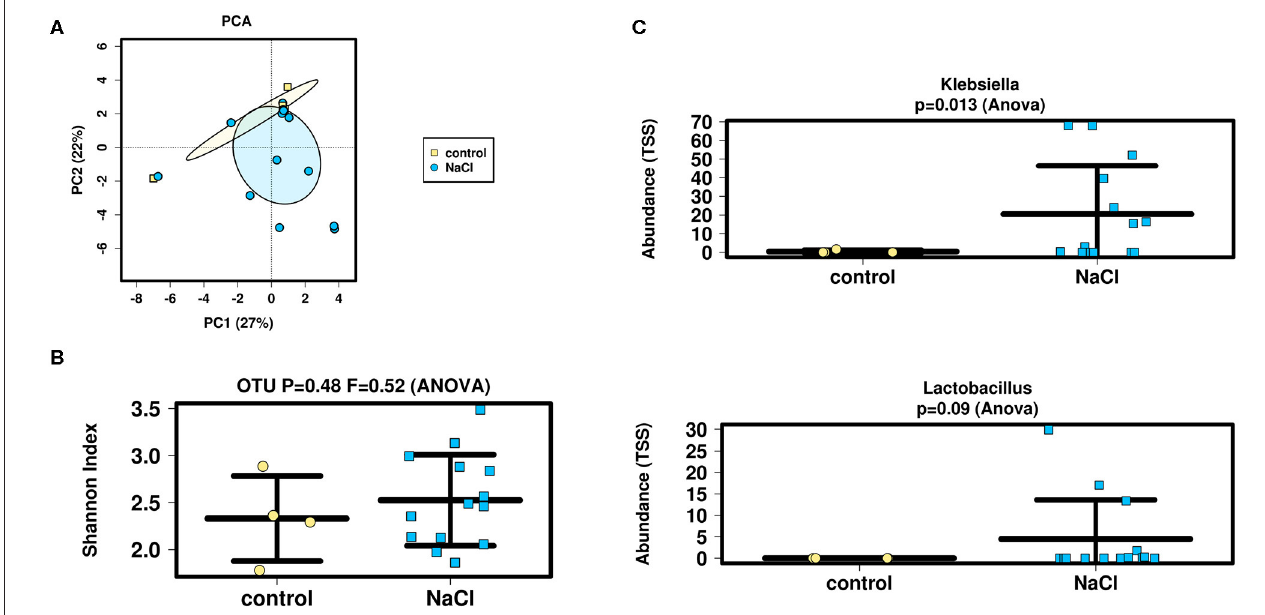
FIGURE 3 | Analysis of microbial diversity and taxa abundance as to treatment (NaCl vs. control) (A,B) PCA and Shannon-Index were performed/applied on/to all samples to evaluate ß- and α -diversity at OTU-level (sequencing depth normalized to 1,911 reads): No significant differences were detected as to inter- and intraindividual microbial variation between groups. (C) TSS was applied to evaluate taxa abundance at genus-level. Analysis showed an increased abundance of Lactobacillus and significantly higher abundance of Klebsiella in the NaCl group. The increase in Lactobacillus strains might indicate a health-promoting effect of NaCl on the intestinal microbiome. Higher abundance of Klebsiella is suggested to arise from an increased susceptibility for infections of predominantly premature infants within the NaCl